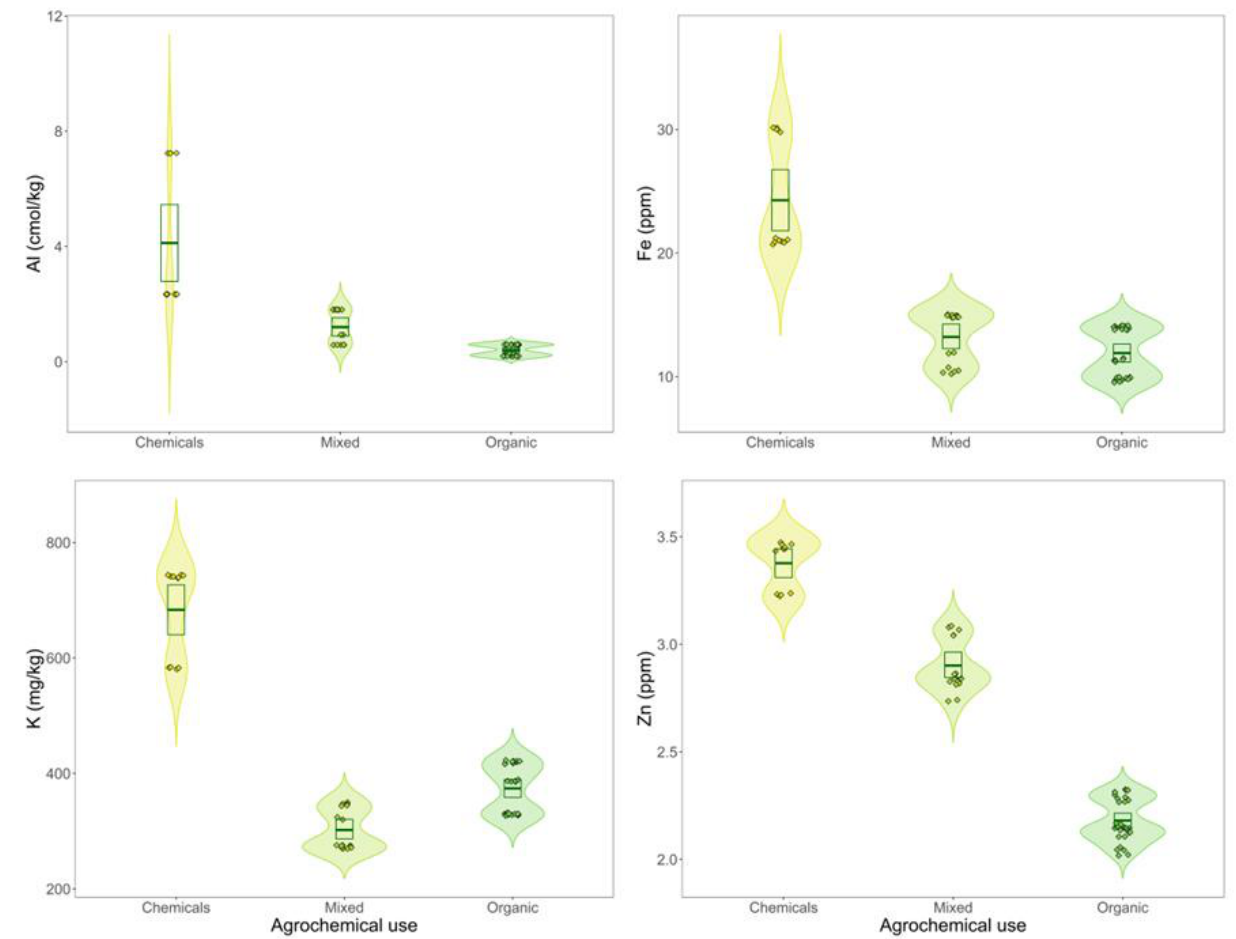
Figure 1. Concentrations of K + , Al 3+ , Fe 3+ , and Zn 2+ in soil samples from 56 coffee home gardens in West Java in relation to the use of chemicals. Data are model predicted values from generalised linear models, and boxes dictate 95% confidence intervals.